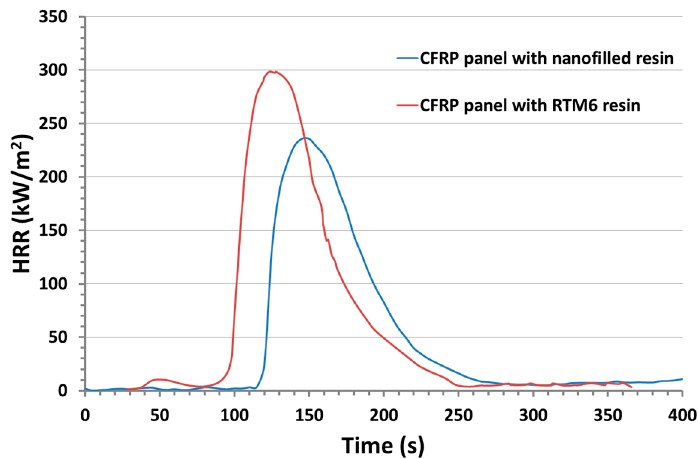
Figure 21. Heat release rate (HRR) of the composite obtained with the nanofilled resin to RTM6 panel. Table 1. Comparison of parameters by cone calorimeter test: time to ignition, tig, HRR results, and total heat release (THR) for measurements performed at irradiance 35 kW / m 2 .